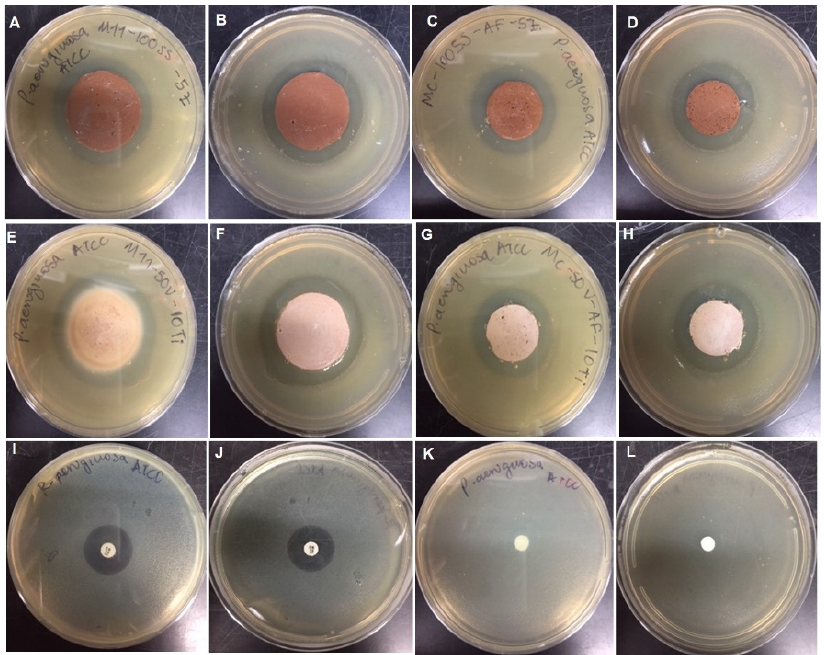
Figure 11. Images corresponding to the culture of P. aeruginosa for different mixtures and the con- trol. Front and rear views are presented, respectively . ( A , B ) Paste 100SS-5Z, ( C , D ) mortar 100SS-5Z- G, ( E , F ) paste 50SS:50G-10Ti , ( G , H ) mortar 50SS:50G- 10Ti-G, ( I , J ) Sensi-disc control of gentamicin, and ( K , L ) Sensi-disc control with no